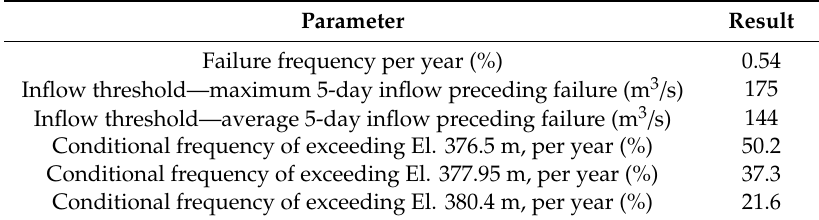
Figure 15. Simulation results from 8842 iterations where all three events occurred and affected one another, with ( a ) reservoir elevations, ( b ) total spill, ( c ) turbine flow, and ( d ) free overflow discharge. Table 1. Criticality parameters for scenario.